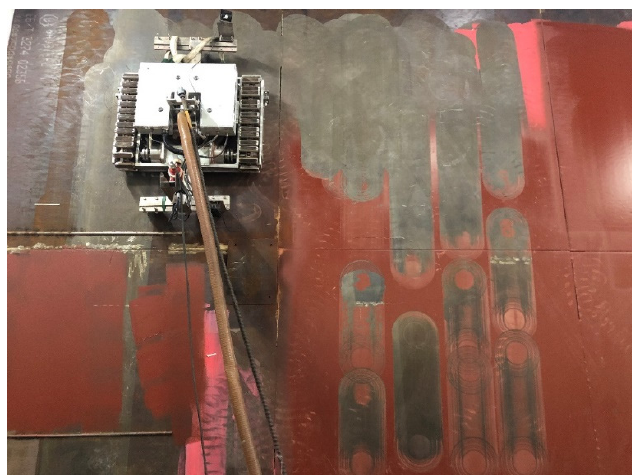
Figure 5. High pressure water jet experimental platform.